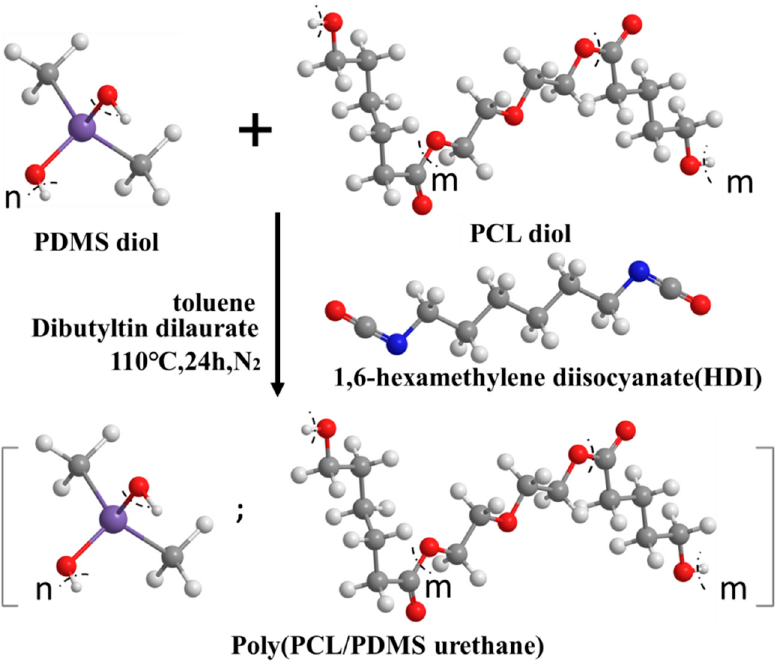
Figure 1. The synthetic procedure to fabricate the polycaprolactone-polydimethylsiloxane (PCL– PDMS)